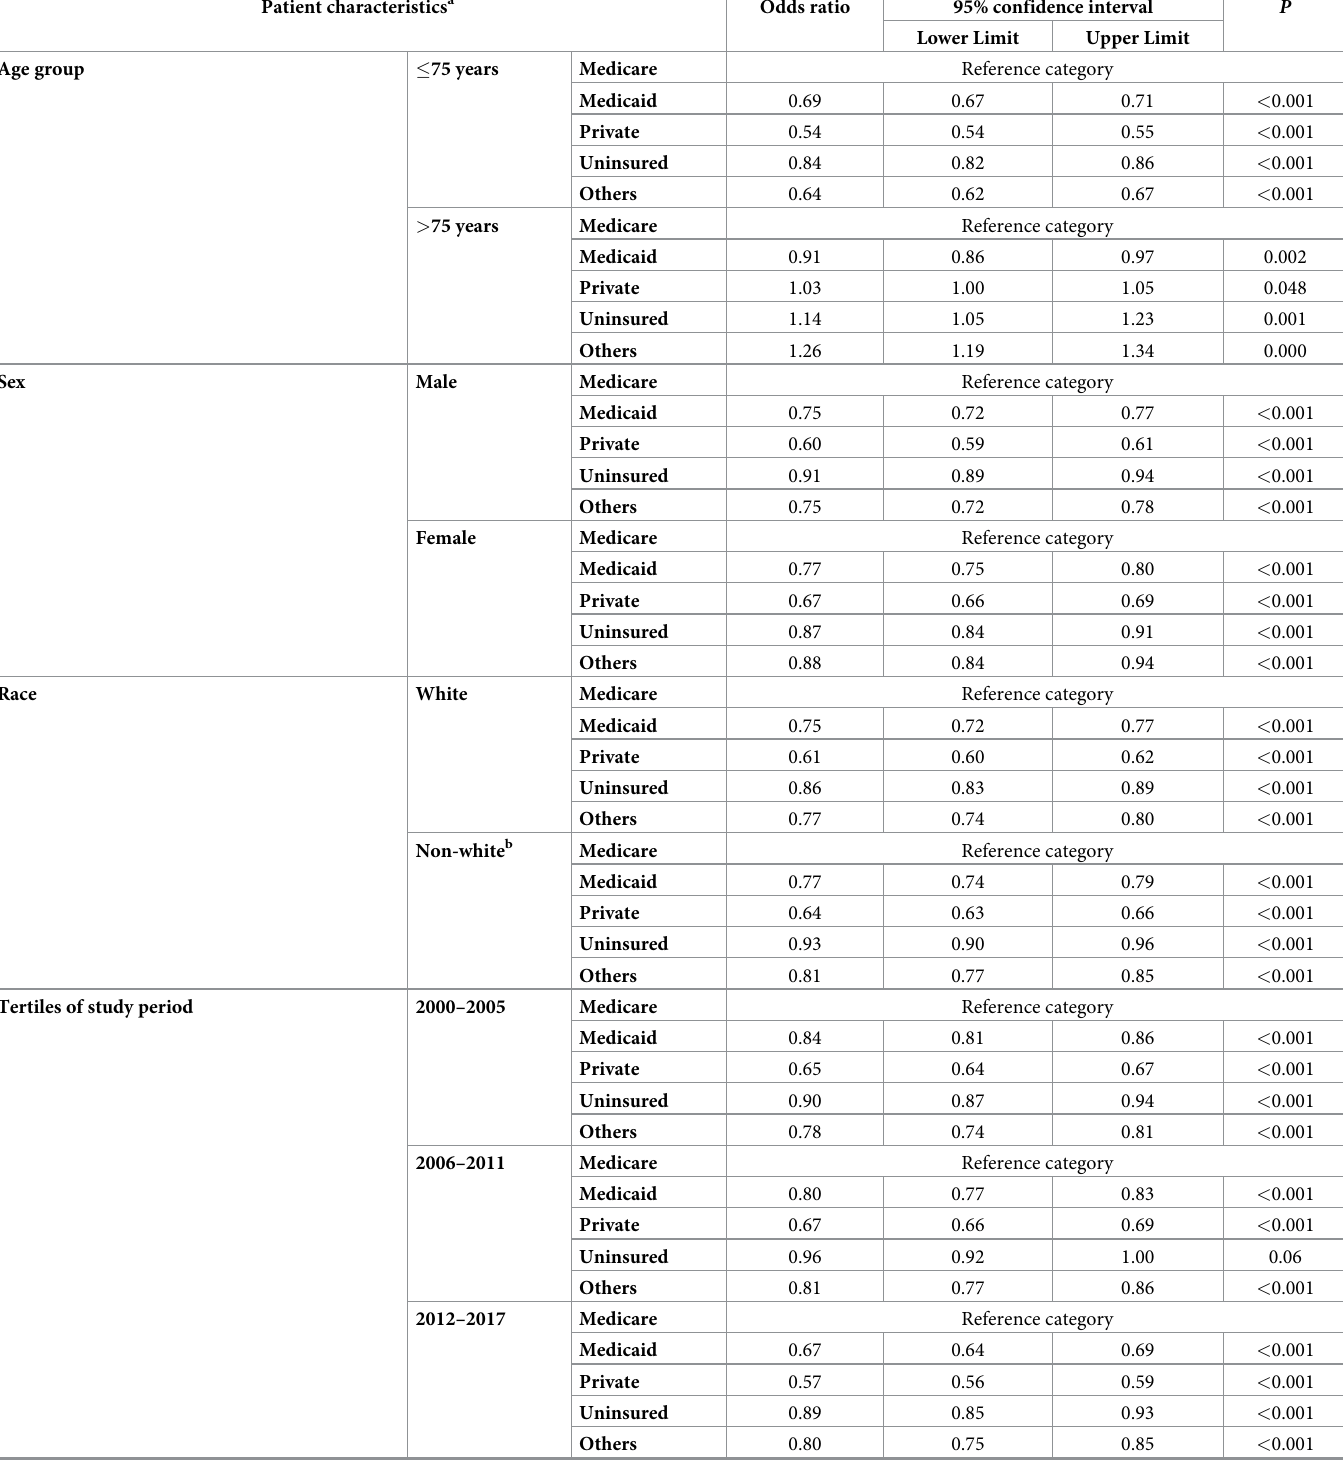
Table 3. In-hospital mortality in STEMI admissions stratified by patient